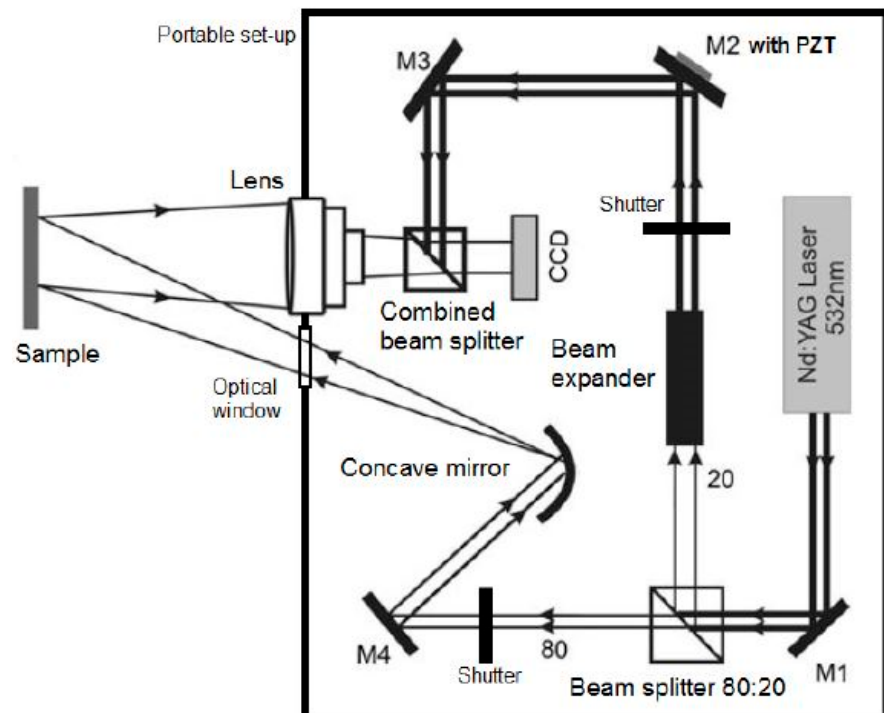
Figure 2. The optical geometry of the DHSPI system follows two paths that are driven by optical elements to produce an interference between the object and an unmodulated beam into a CCD camera .